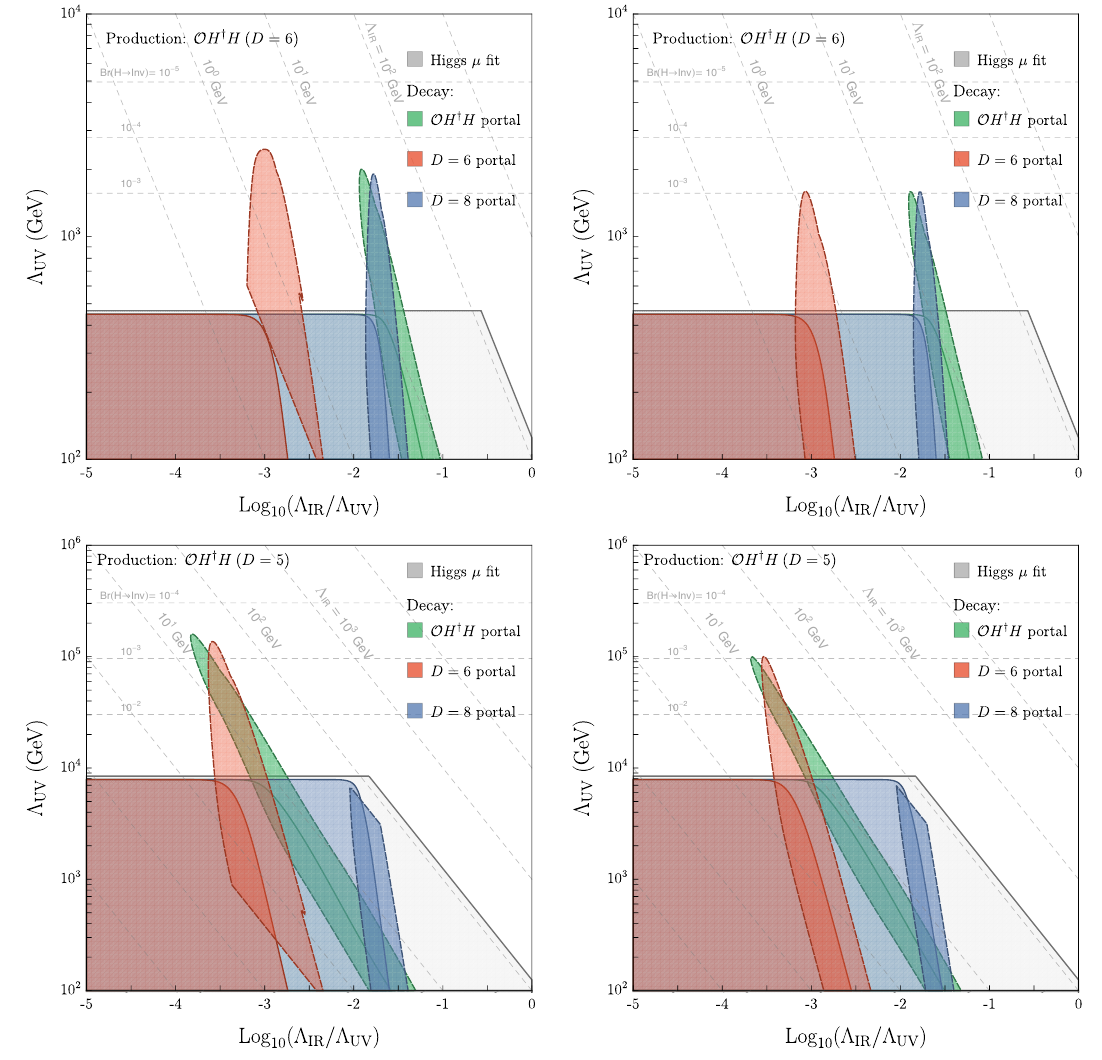
Figure 5 . Constraints on resonant DS production through a D = 6 (upper panels) and D = 5 (lower panels) Higgs portal. Plots on the left (on the right) assume a strongly (weakly) coupled dark sector. Exclusion regions from the bound on the Higgs invisible width of ref. [56] (solid contours) and the searches for displaced vertices of refs. [57, 58] (dashed contours) are shown for three different types of LDSP decay portal: the same Higgs portal responsible for the production (green), generic D = 6 (red) and D = 8 (blue) portals. Also shown in gray is the exclusion from the LHC fit to Higgs data of eq. (4.7). All the plots assume κ 2 c i = 1 for the various portals. i √ From Run1 at s = 8 TeV we considered the mono-jet search of ref. [63]. All of these studies have found signals consistent with a pure SM background and set constraints on from the mono-jet analysis at 13 TeV and is comparable to that from the Z width at LEP. The corresponding exclusion region is shown in figure 6 (solid contours) for two choices of the LDSP decay portal: the same Z portal, and a generic D = 8